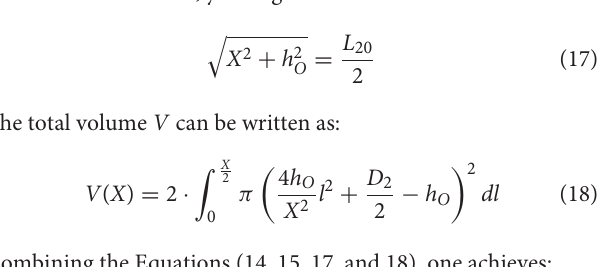
sensor. One end of the actuator is fixed to the base, and the other end is connected to the external tension sensor via